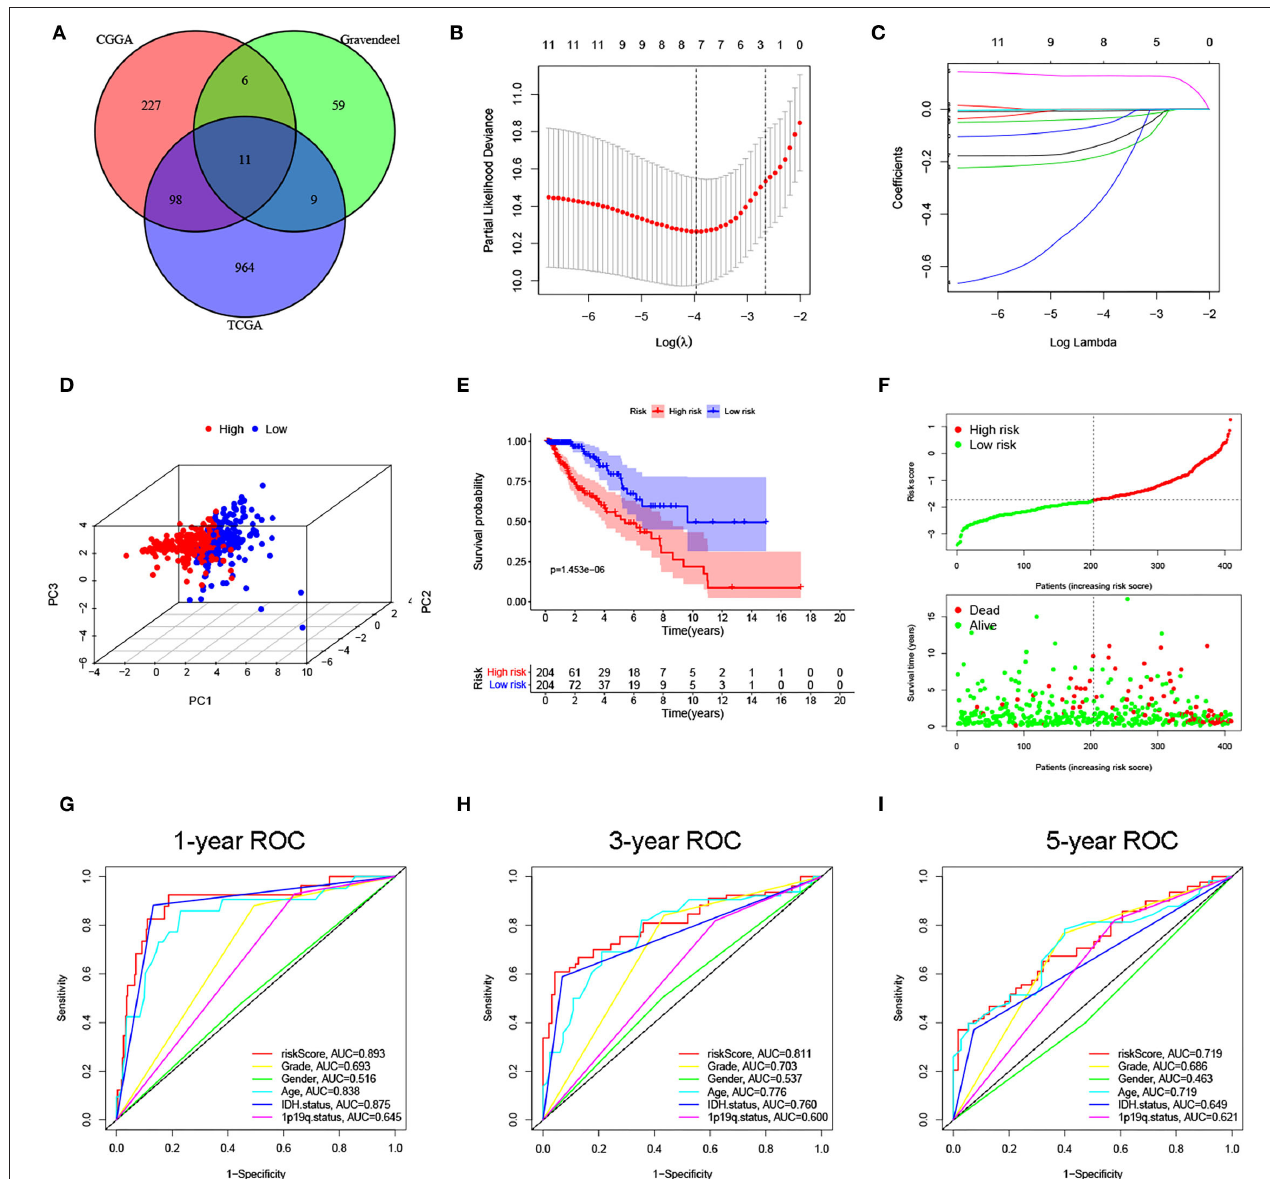
FIGURE 2 | Construction of a ferroptosis-related long noncoding RNAs (lncRNA) signature for lower-grade glioma (LGG) in The Cancer Genome Atlas (TCGA) cohort. (A) Overlapping prognostic lncRNAs in 3 cohorts were screened out. (B,C) Minimum criteria and coefficients were calculated by least absolute shrinkage and selection operator (LASSO) analysis. (D) The distribution difference is shown between the two subgroups by PCA. (E) Kaplan–Meier curve of the two subgroups. (F) The distribution plot of risk score, survival status, and overall survival (OS) time. (G–I) area under the curve (AUC) values of 1-, 3-, and 5-year OS for the risk score and clinical